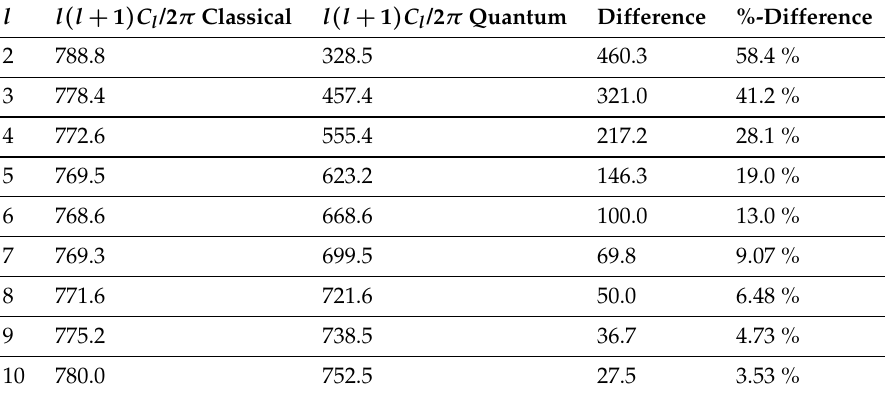
Table 1. Values of, and percentage differences between, the classical predictions for the angular spectrum coefficients C l ’s, and the prediction with a quantum RG running for Newton’s constant G included. The quantum gravity values for the C l ’s were computed here with a lattice RG running quantum amplitude of 2 c 0 = 16.04/7 =